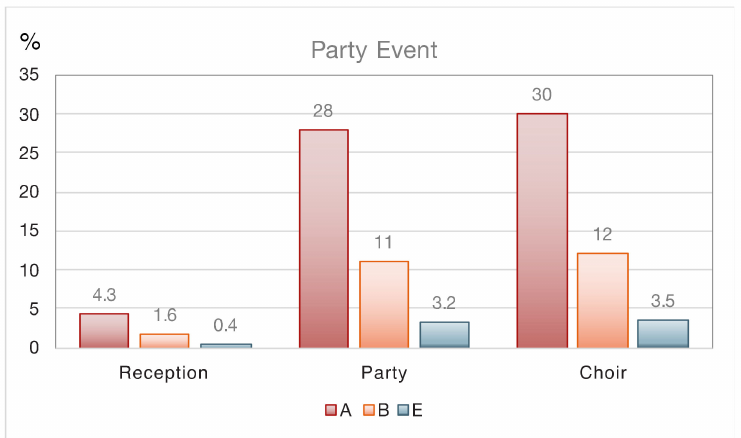
Figure 2. Individual risk of a particular person being infected (equivalent to the percentage of the group being infected), comparing a party with a reception and a choir practice, for three scenarios. Scenario A: passive ventilation, no masks. Scenario B: active ventilation with outside air, no